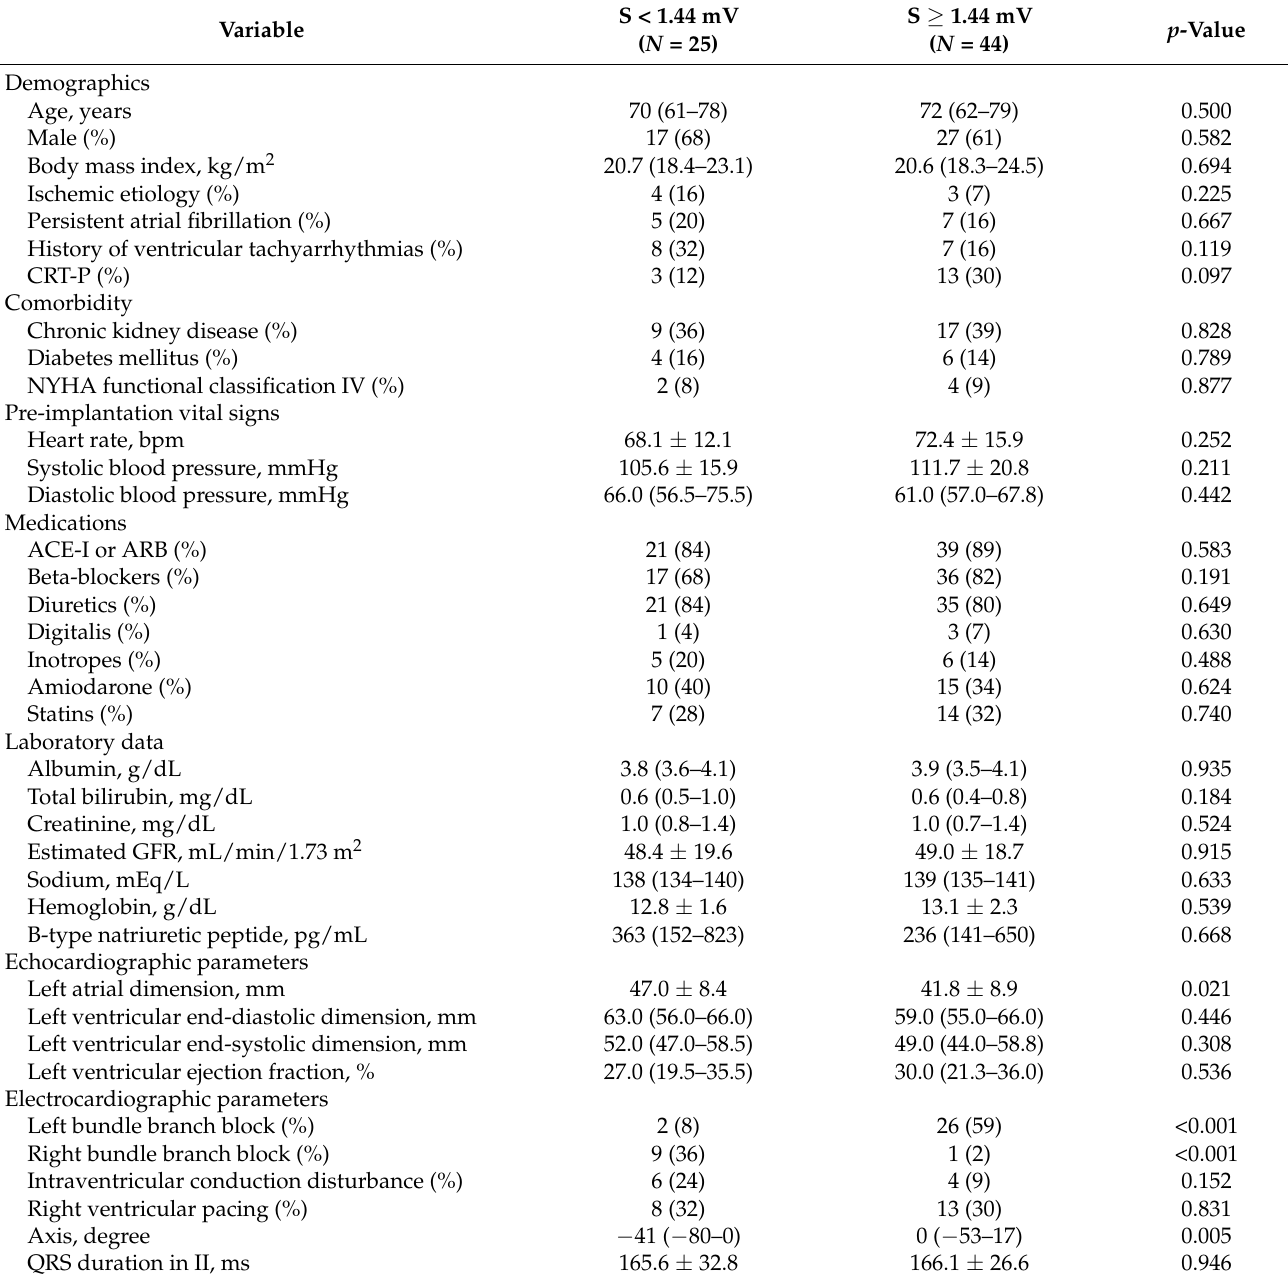
Table 3. Comparison of baseline characteristics between patients with averaged S-wave in right precordial leads <1.44 mV and those with averaged S-wave ≥ 1.44